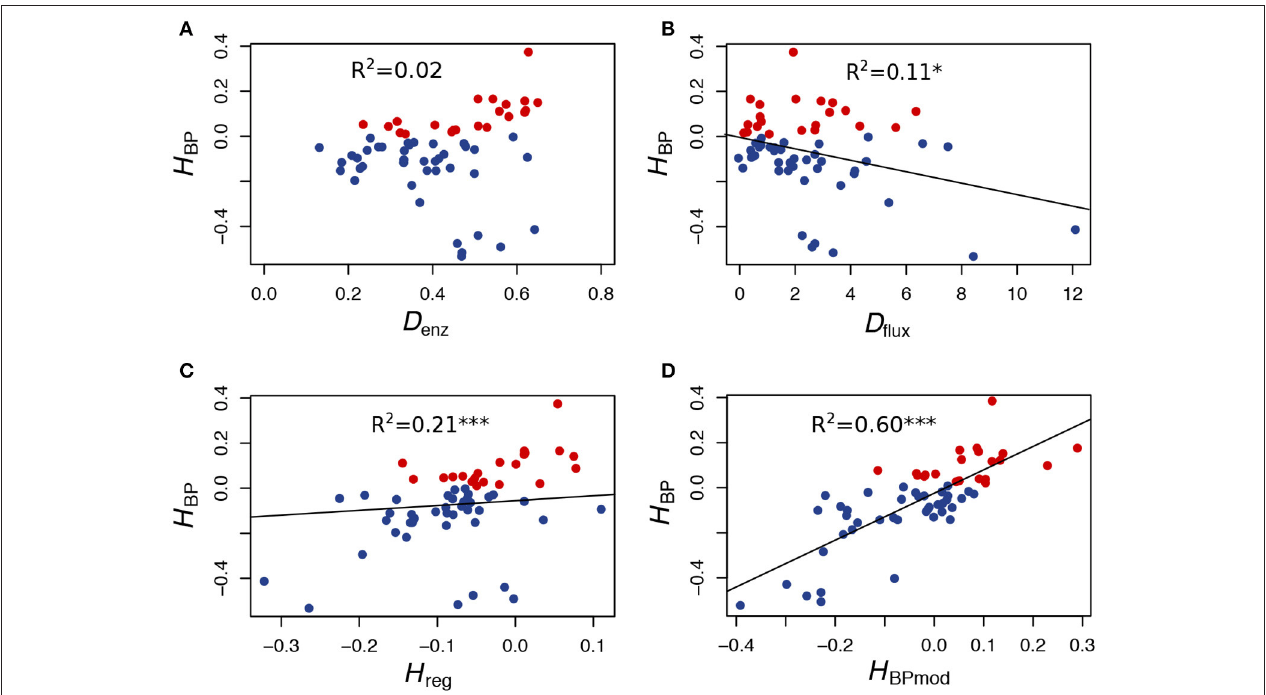
FIGURE 6 | In vitro heterosis predictors. (A) Relationship between H BP and D enz , the Euclidean distance between parents computed from enzyme concentrations ( r 0.15, p < 0.25). (B) Relationship between H BP and D flux , the flux difference between parents ( r = heterosis value computed from the equation of the multiple linear regression performed with D enz and D flux as predictor variables ( r Relationship between H BP and H BPmod , the expected heterosis value computed from the model (see text) ( r positive H BP , i.e., to BPH.